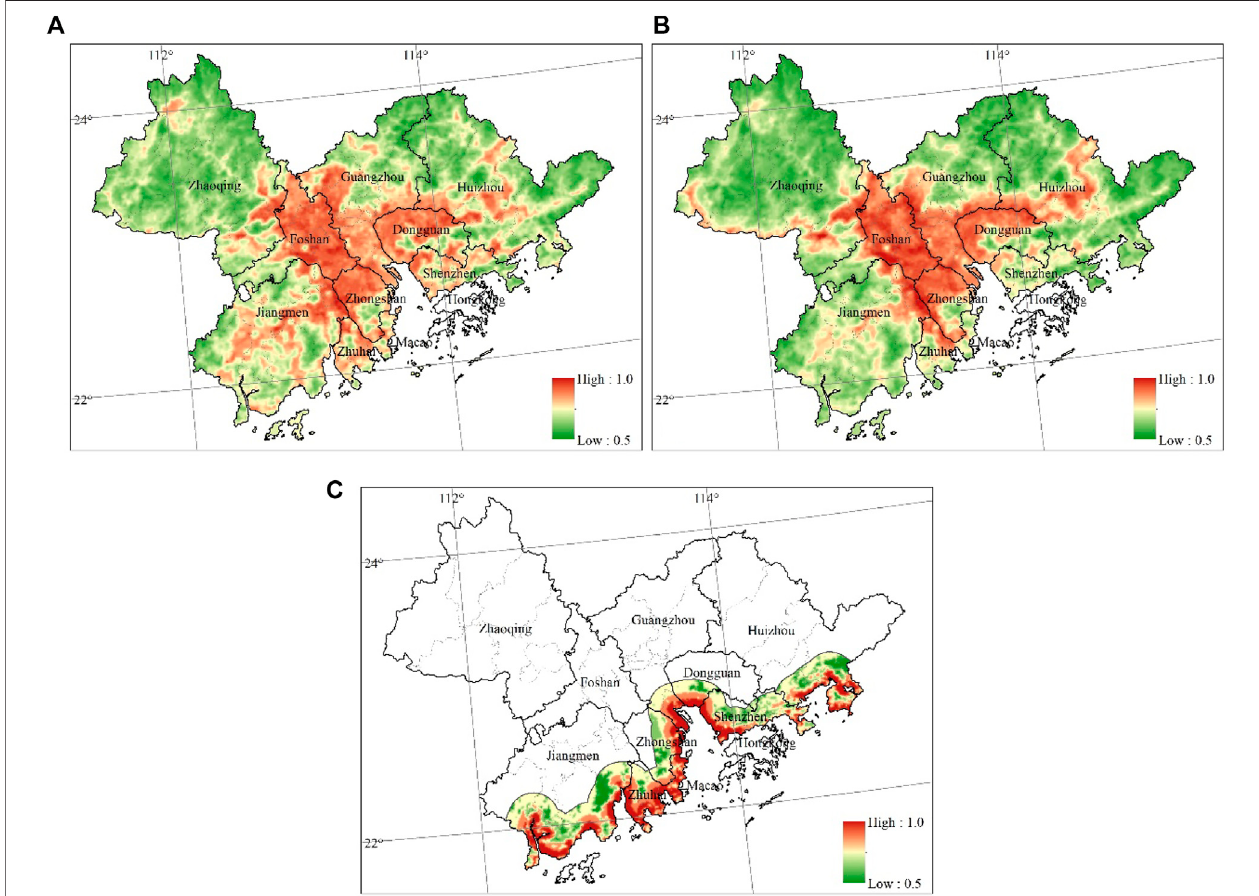
FIGURE 8 | Vulnerability for (A) typhoon – gale, (B) typhoon – rainstorm, and (C) typhoon – storm surge disaster chains in the GBA in 2015.